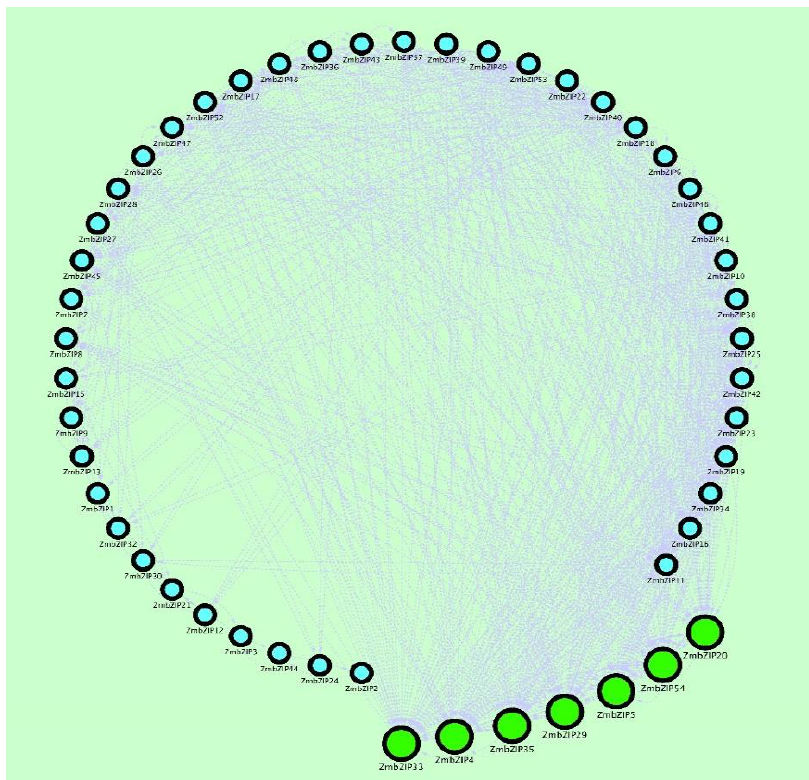
Figure 9. Co-expression network map of ZmbZIP genes. The Cytoscape software was used to map the co-expression network between 54 ZmbZIP genes ( p > 0.5). The straight line represents the regulatory relationship of gene existence, and the number of relationships between a gene and surrounding genes in the network indicates that there are more genes that interact with it. A large green circle indicates that the gene is more connected to surrounding genes.